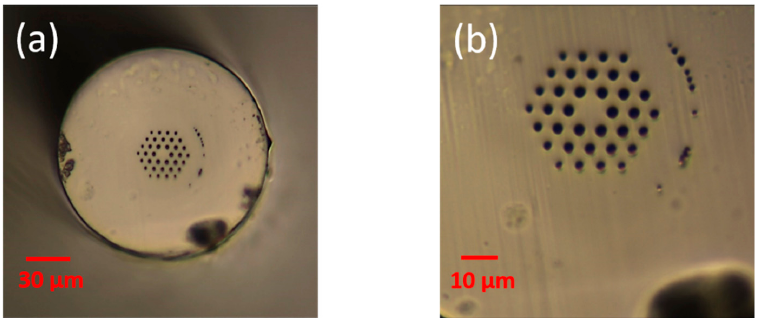
Figure 1. Cross-sectional image of polycarbonate (PC) microstructured polymer optical fiber (mPOF) after cleaving at 80 °C. The endlessly single mode fiber was manufactured at DTU Fotonik with a core diameter of 9 μ m and a cladding diameter of 146 with a dimension scale of 30 μ m ( a ) and 10 μ m ( b ), respectively.